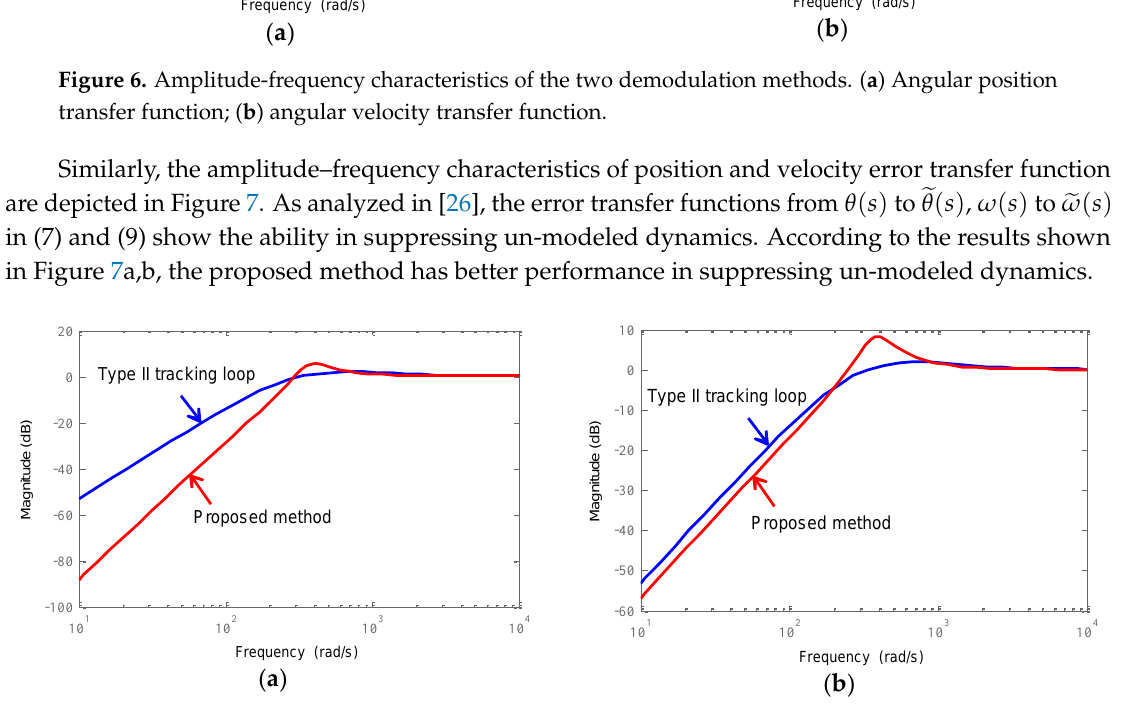
Figure 7. Amplitude-frequency characteristics of the two demodulation methods. ( a ) Angular position error transfer function; ( b ) angular velocity error transfer function.